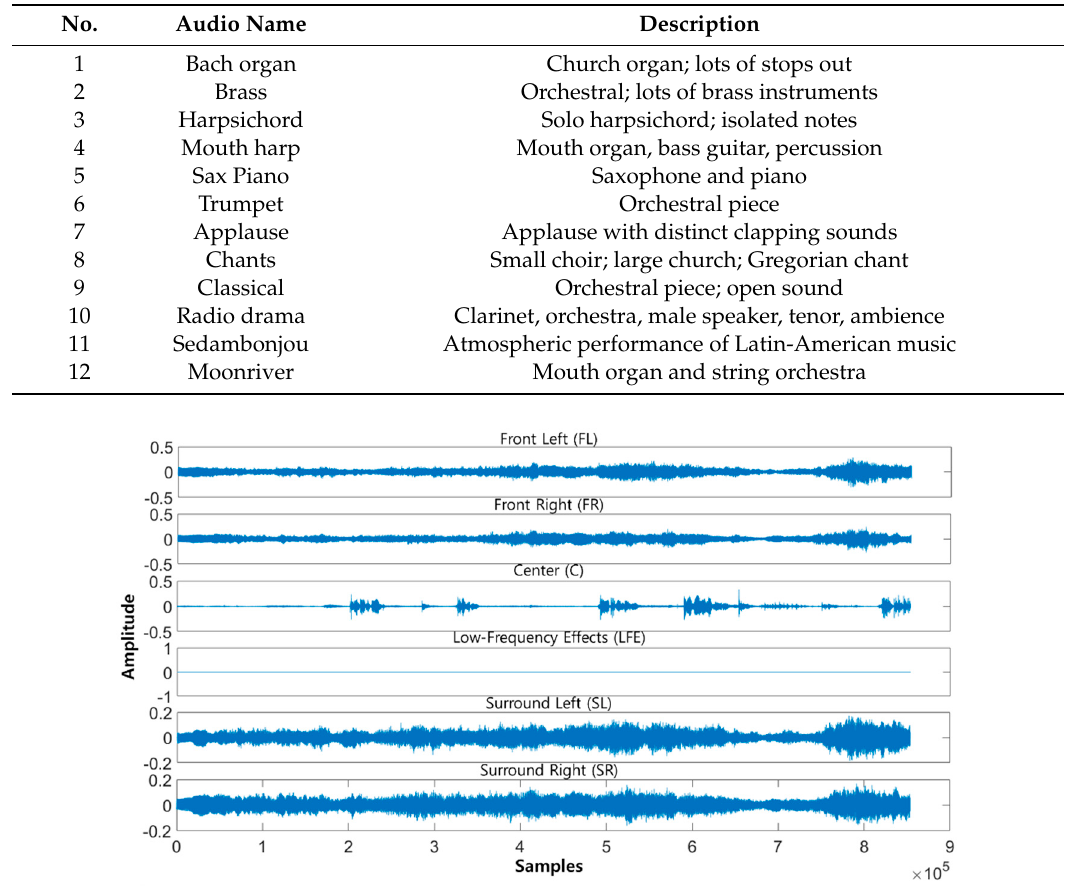
Figure 13. Time domain waveforms of the “Bach organ” 5.1 channel audio.